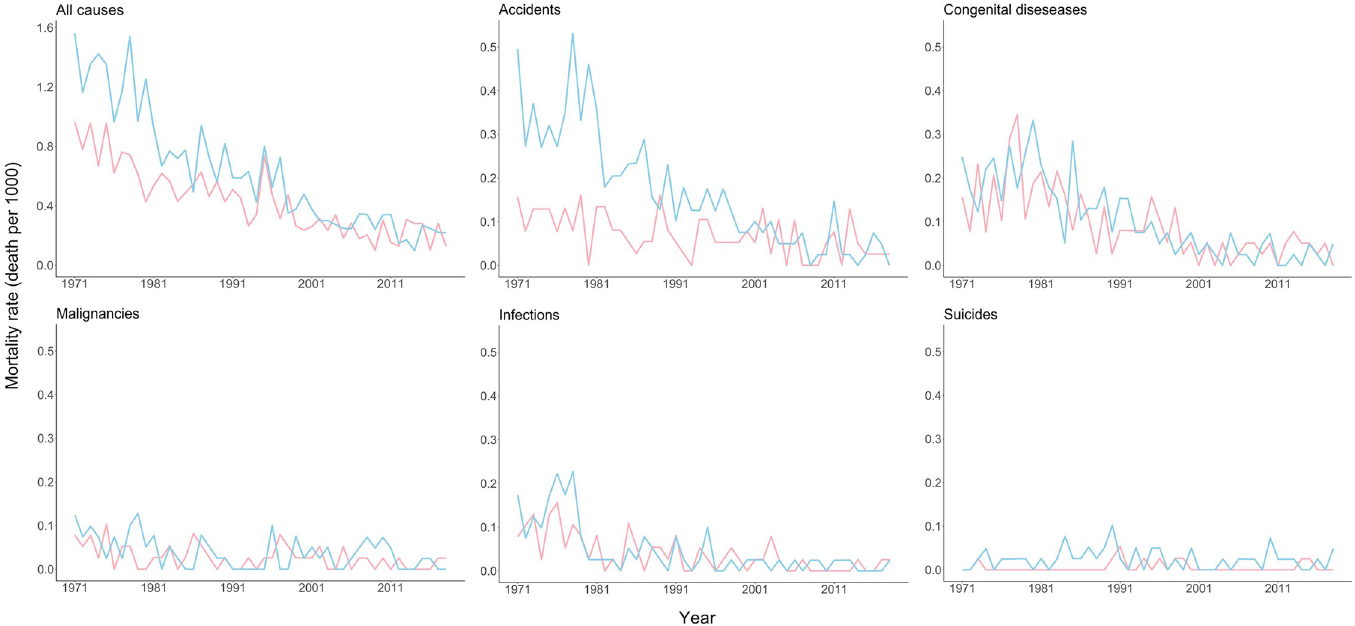
Fig 3. Gender ratios for all causes of childhood deaths and four different categories in Iceland during 1971–2018.